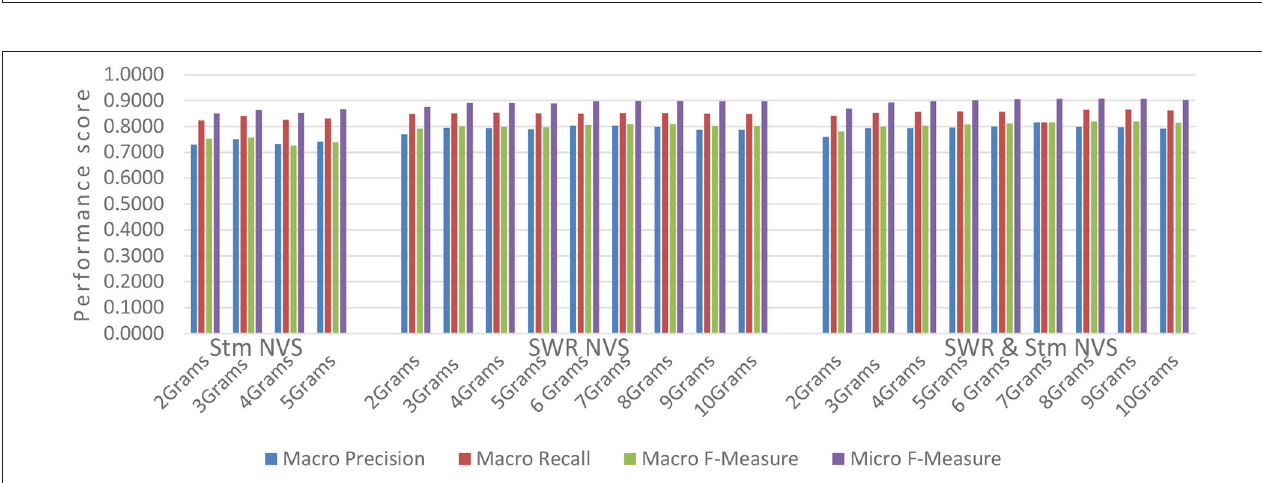
FIGURE 12 | Evaluating preprocessing techniques with Reuters-21578 and containment similarity.